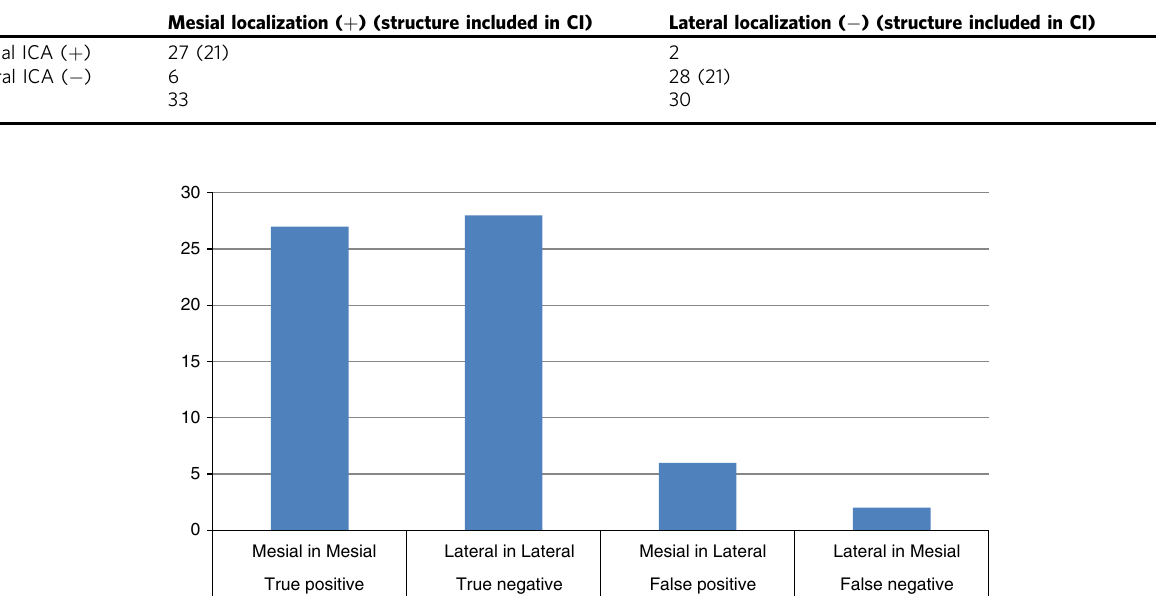
Fig. 6 True and false positive for mesial ICA